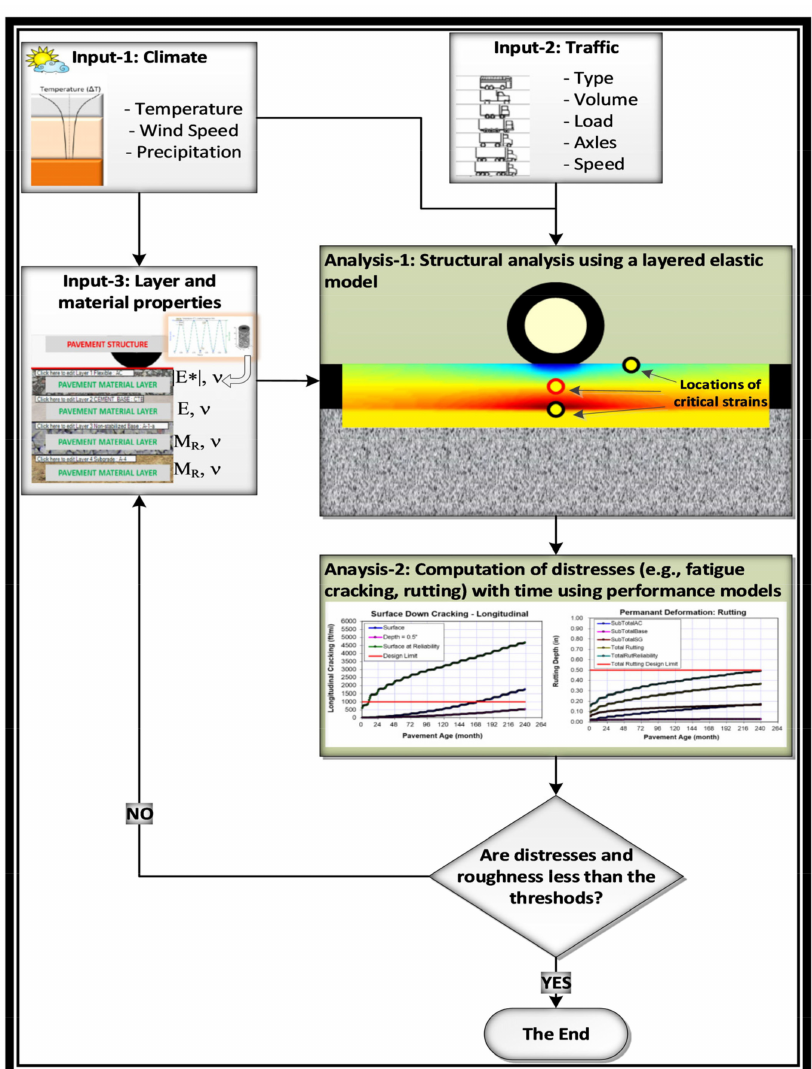
Figure 6. Overall framework of MEPDG